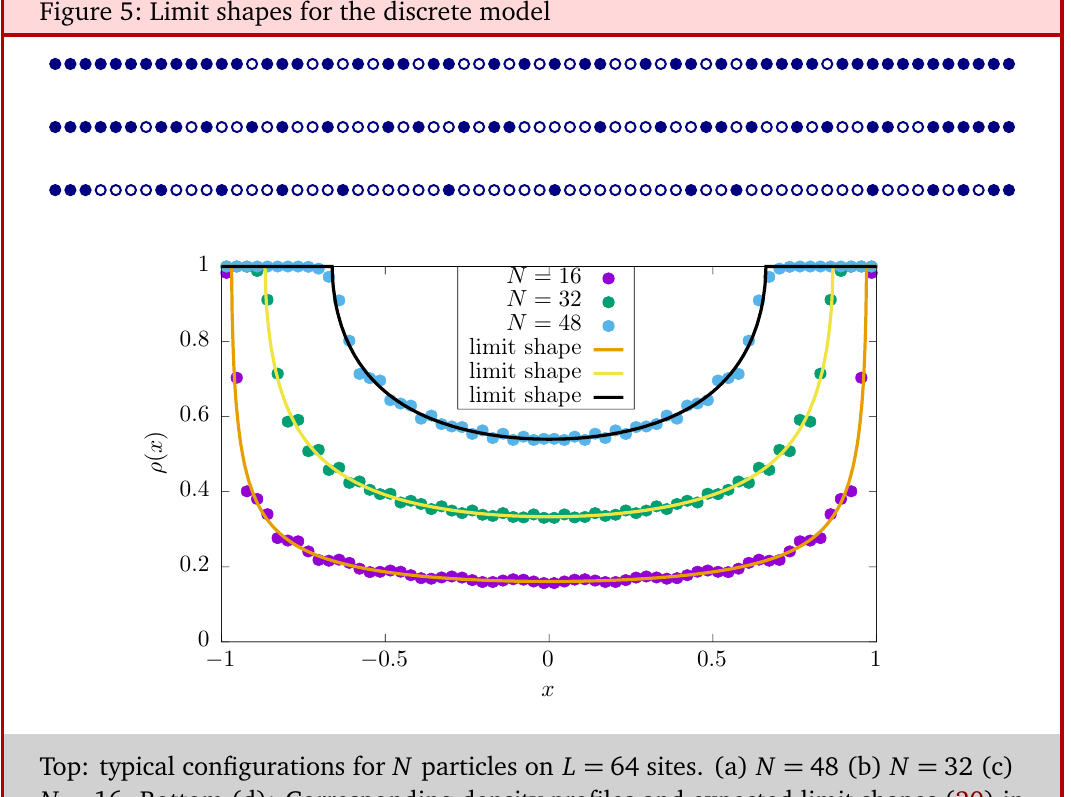
N = 16. Bottom (d): Corresponding density profiles and expected limit shapes (20) in the thermodynamic